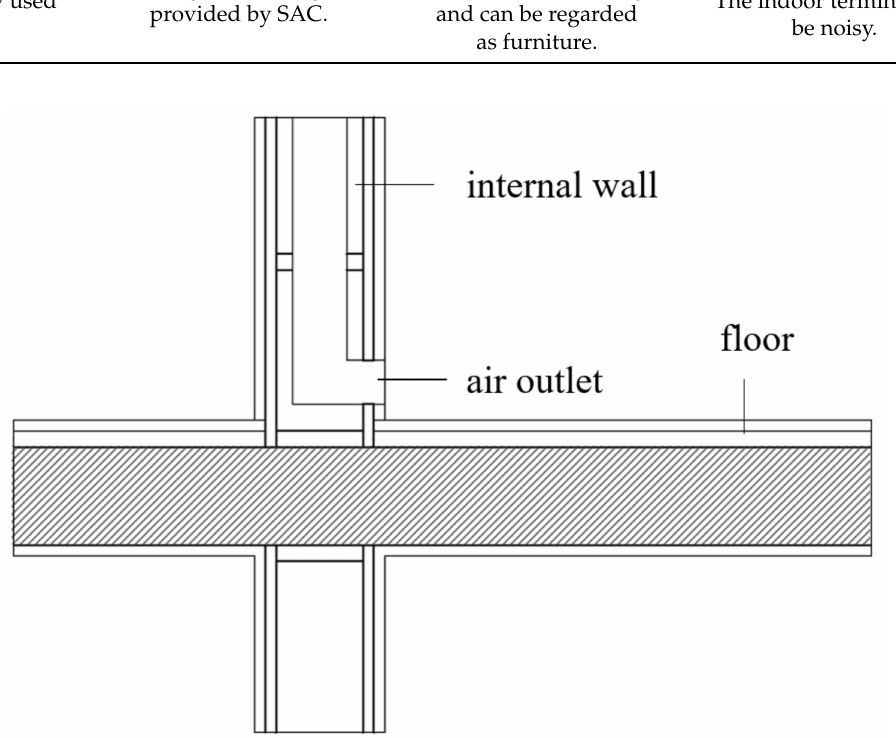
Figure 6. The outlet integrated at the skirting